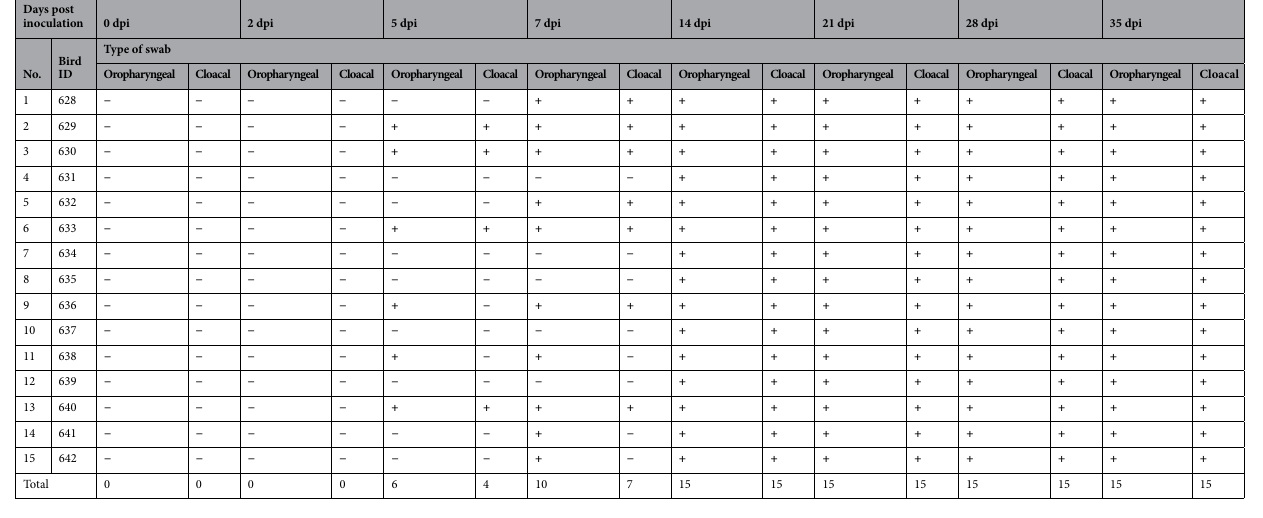
Table 1. Results of testing of oropharyngeal and cloacal swabs for the presence of C. gallinacea